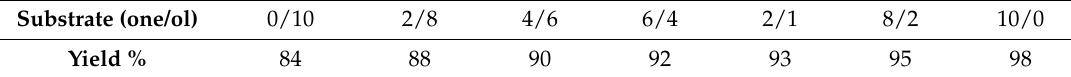
Table 3. Catalytic oxidation of various cyclohexanone/cyclohexanol mixtures towards AA over catalyst 1 . 1